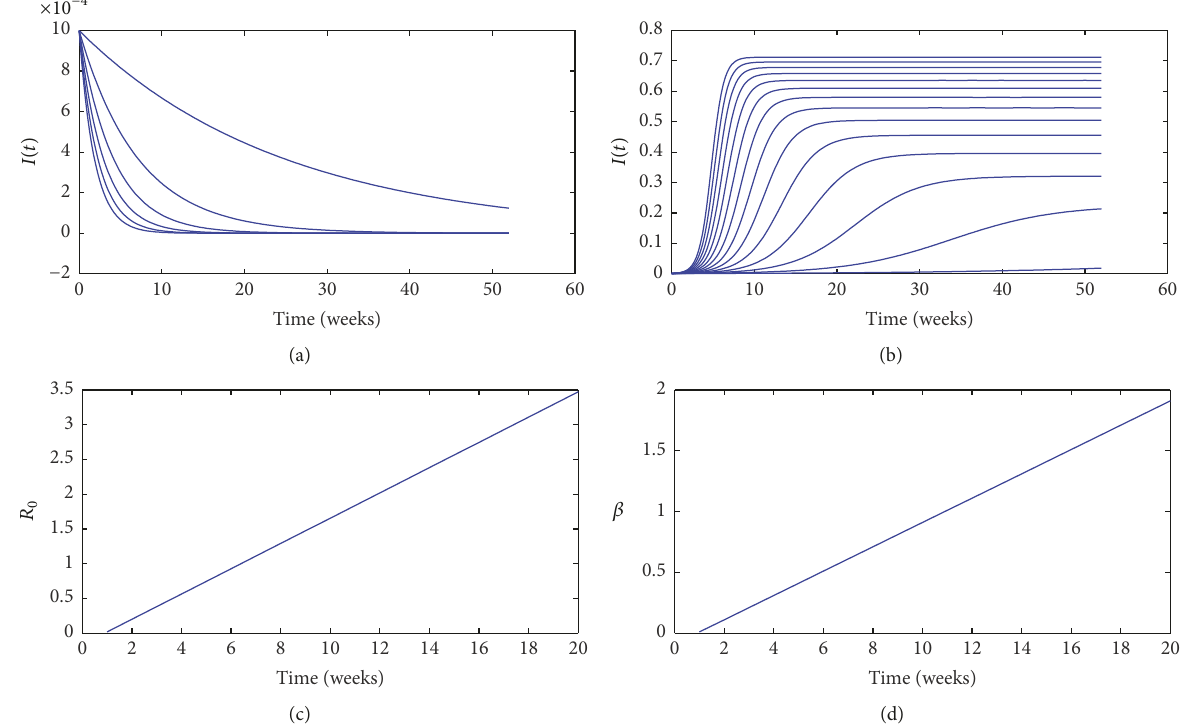
Figure 1: (a) Variation of infected population fraction when 𝑅 0 < 1 . (b) Variation of infected population fraction when 𝑅 0 > 1 . (c) Corresponding 𝑅 0 variation. (d) Corresponding 𝛽 : this simulation is done, fixing 𝛾 = 0.55